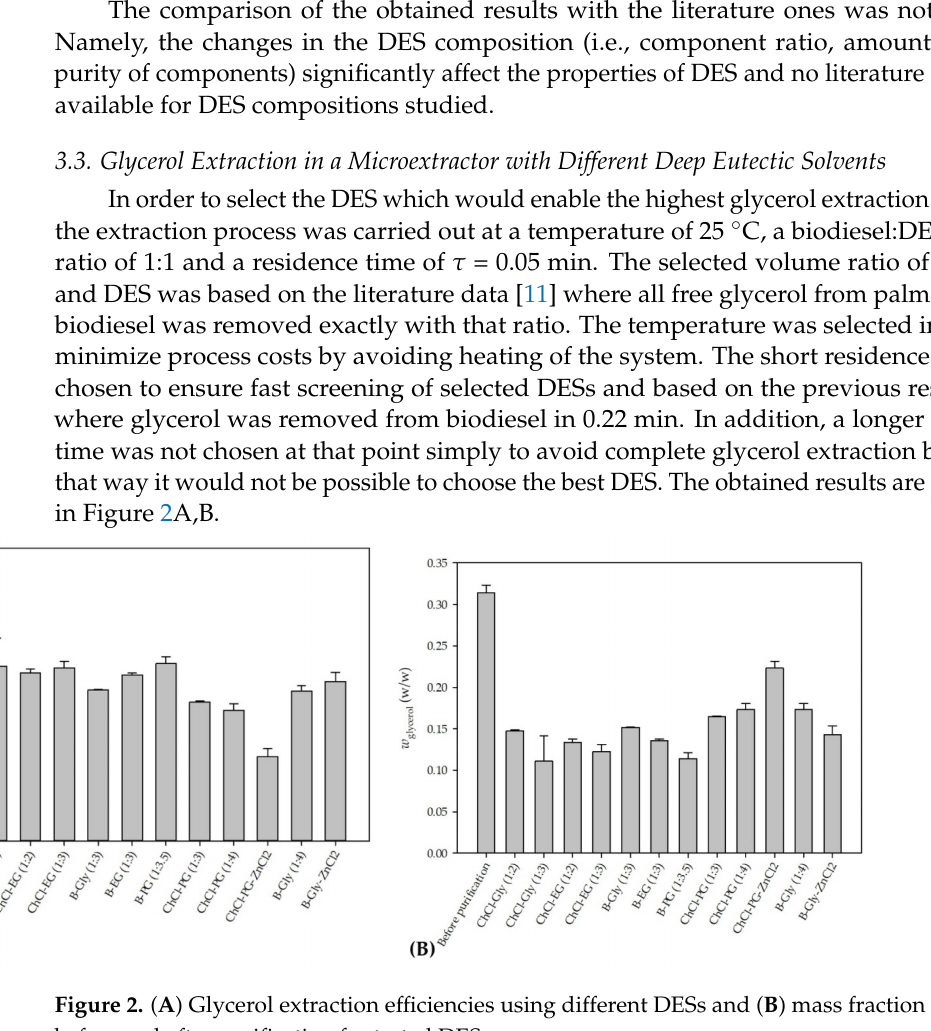
Figure 2. ( A ) Glycerol extraction efficiencies using different DESs and ( B ) mass fraction of glycerol before and after purification for tested